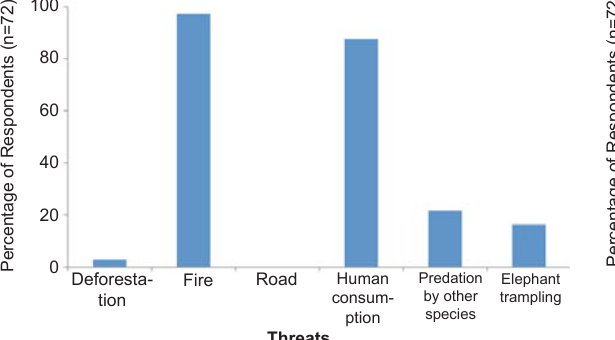
Figure 3. Threats faced by Indotestudo travancorica and Vijayachelys silvatica in the study area